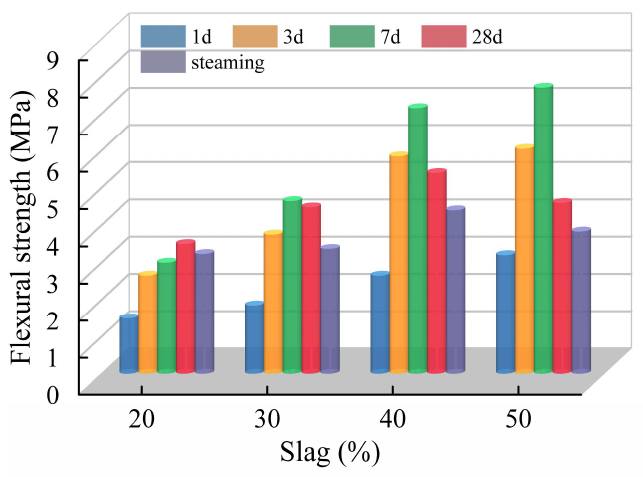
Figure 15. Effect of slag content on flexural strength.